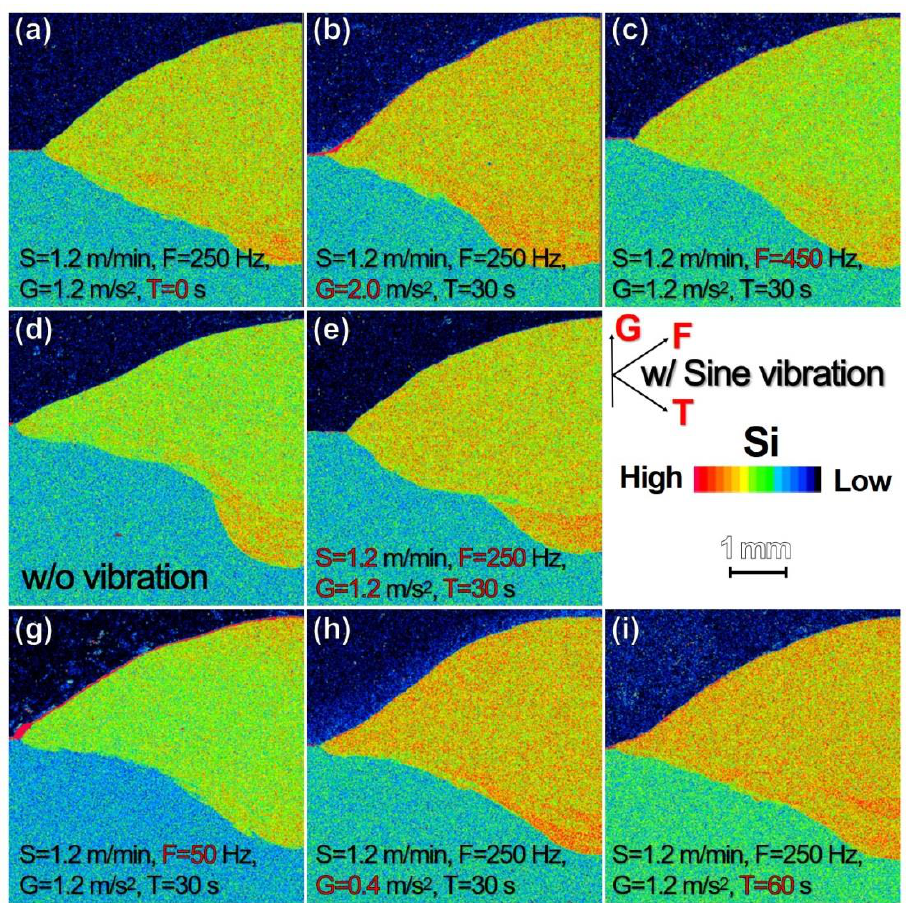
Figure 9. EPMA-Si maps for TP-GMAW specimens at specific S, F, G, and T, e.g., ( e ) for the specimen at 1.2 m/mm (F = 250 Hz, G = 1.2 m/s 2 and T = 30 s), and for comparison, ( d ) the specimen w/o vibration.